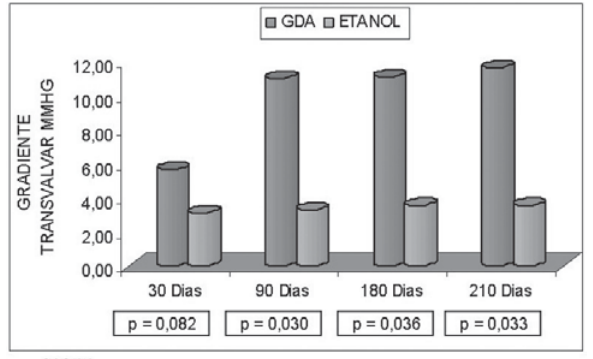
Fig. 8 - Gradiente transvalvar nos grupos de